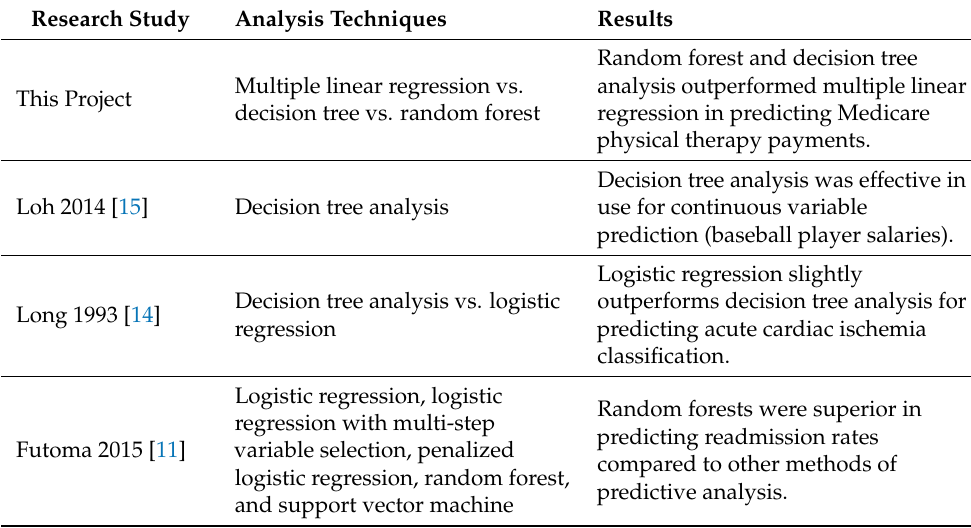
Table 1. Comparison of research projects and analysis